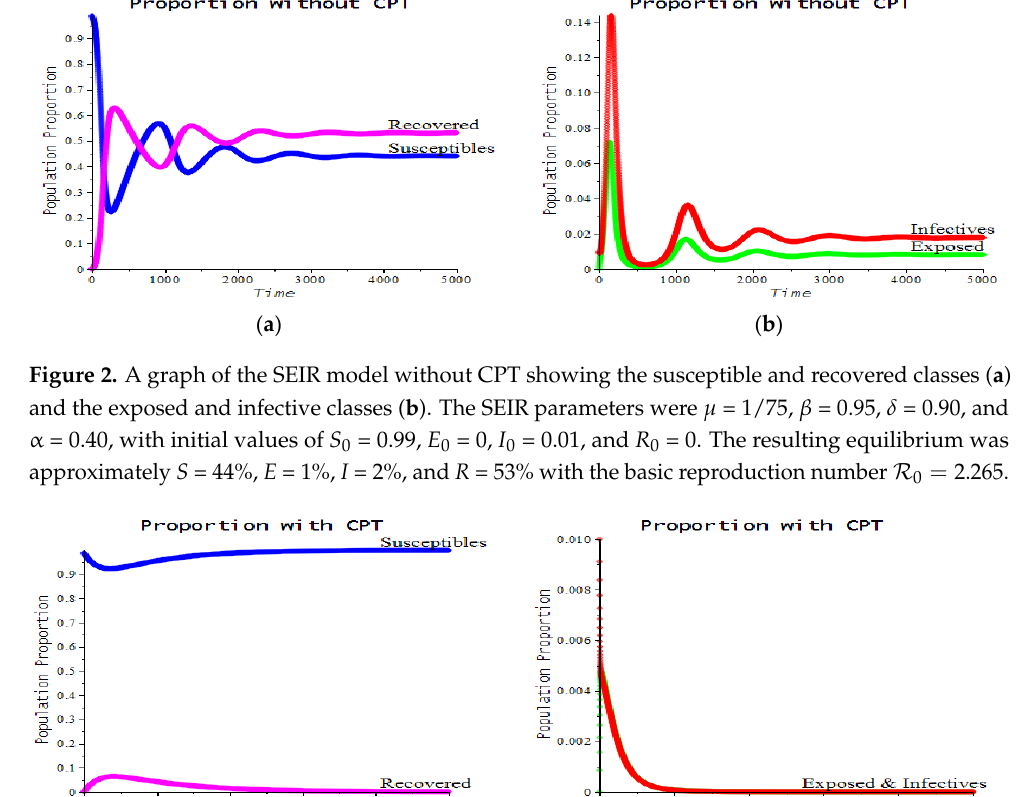
and the exposed and infective classes ( b ). The SEIR parameters were μ = 1/75, β = 0.95, δ = 0.90, and α = 0.40, with initial values of S 0 = 0.99, E 0 = 0, I 0 = 0.01, and R 0 = 0. The CPT rate was assumed to be ε = 0.55. The resulting equilibrium was approximately S = 99%, R = 0.05%, and the remaining E and I were nearly zero. In this case, the resulting effective reproduction number was R 0 = 0.97 (less than 1).